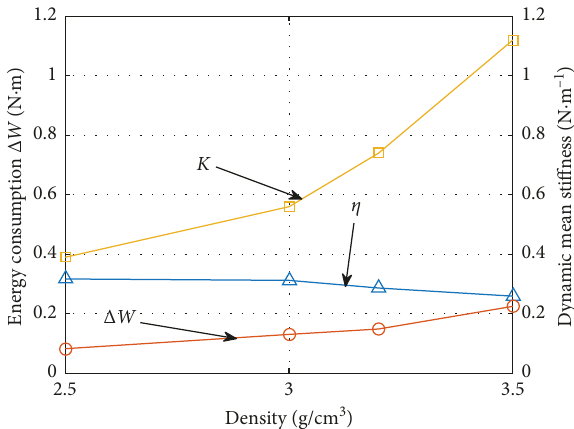
Figure 12: Loss factor and dynamic average stiffness K with changing density. η is the dissipation factor.